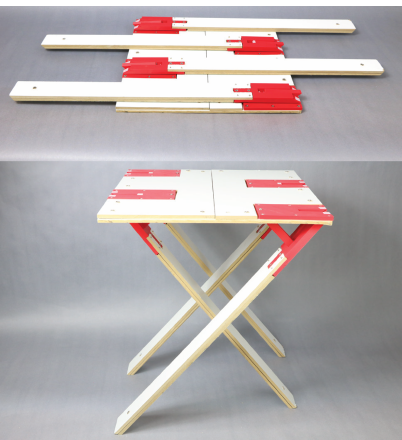
Figure 30. Flat-foldable side table example. The planar deploying strut ThUDS used are similar to those shown in Fig. 10.